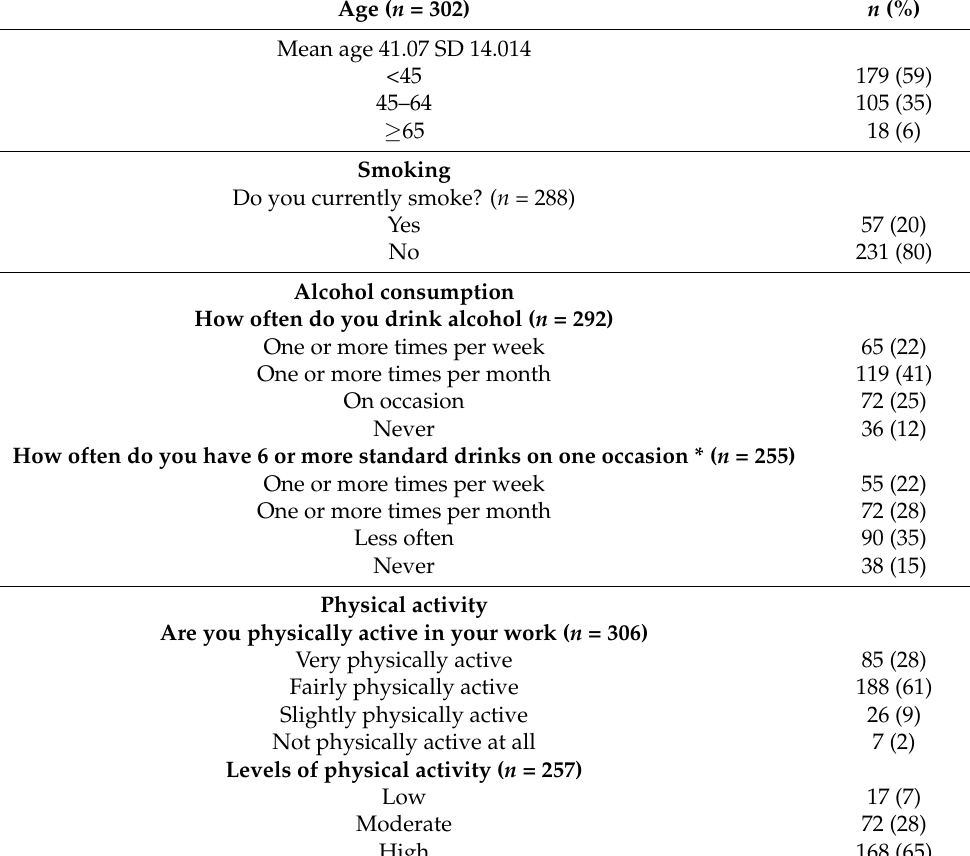
Table 1. Socio-demographic and farm